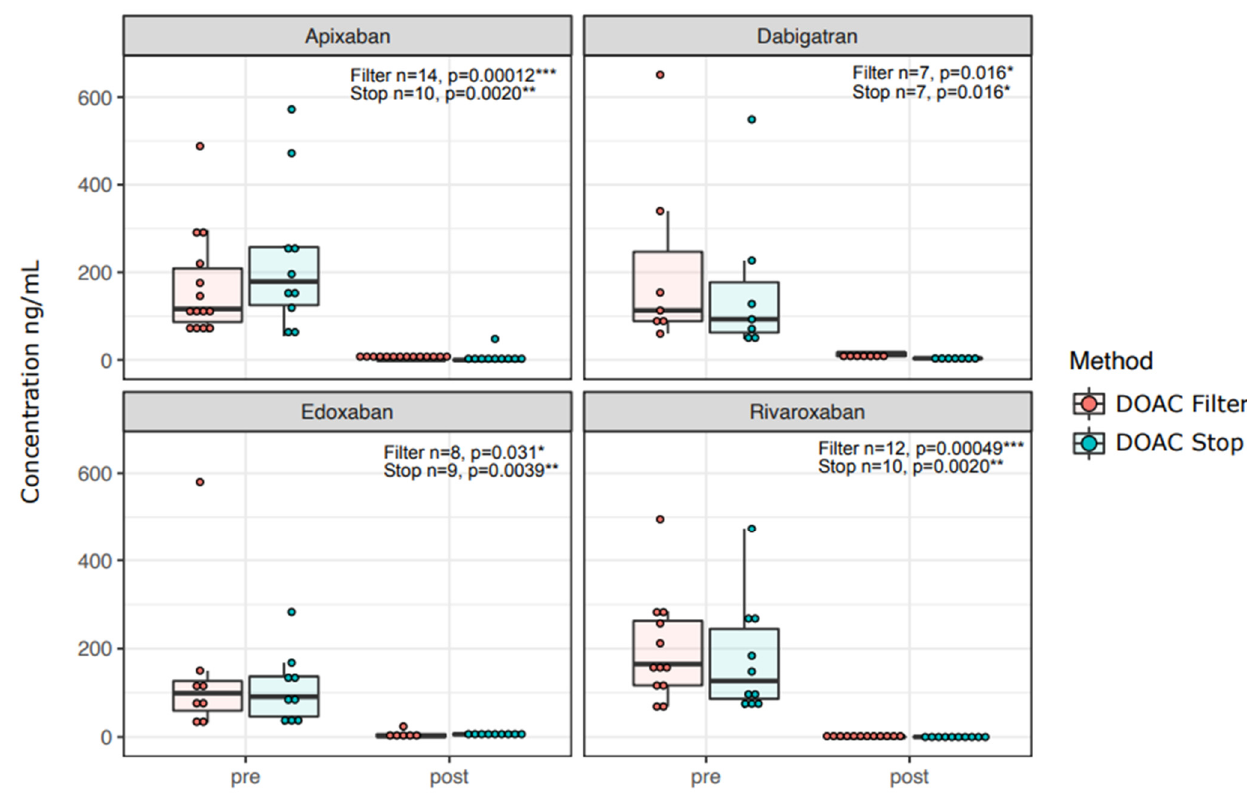
Figure 1. DOAC concentrations are effectively reduced by both DOAC Filter ® and DOAC-Stop™. Concentrations of DOACs (as ng/mL) before (pre) and after (post) DOAC removal via DOAC Filter ® or DOAC-Stop™ are shown. The paired sign test was used to test for significance. Asterisks: *: p < 0.05; **: p < 0.01, ***: p < 0.001